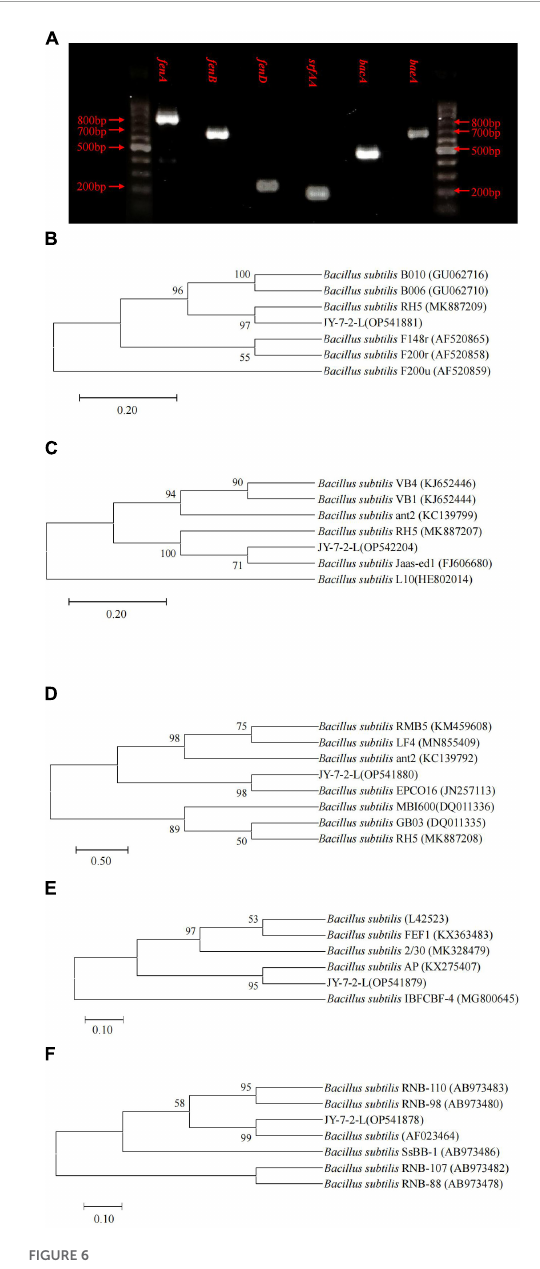
FIGURE6 Detection of functional genes involved in antifungal metabolites synthesis of JY-7-2L. (A) Agarose gel-electrophoresis of PCR fragments of secondary metabolites synthesis genes of JY-7-2L. The Neighbor-Joining trees based on (B) surfactin ( srfAA ), (C) bacilysin ( bacA ), (D) fenD , (E) fenB , and (F) fenA of JY-7-2L and reference strains. Accession numbers were indicated in brackets. Bootstrap values greater than 50% were indicated on the branches.